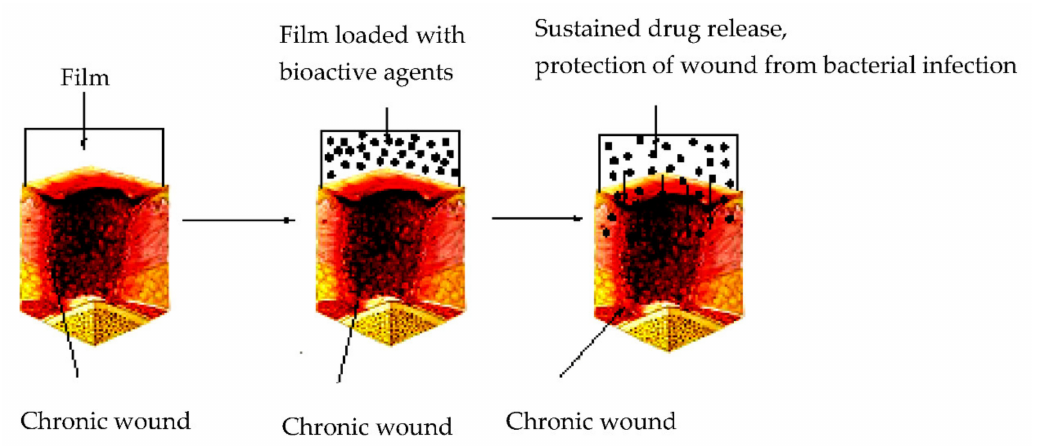
Figure 4. Films for wound dressing [2]. Reprinted from an open-access